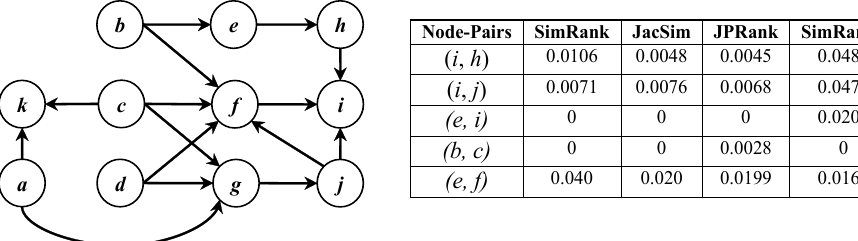
Figure 1. A sample graph and similarity scores of some